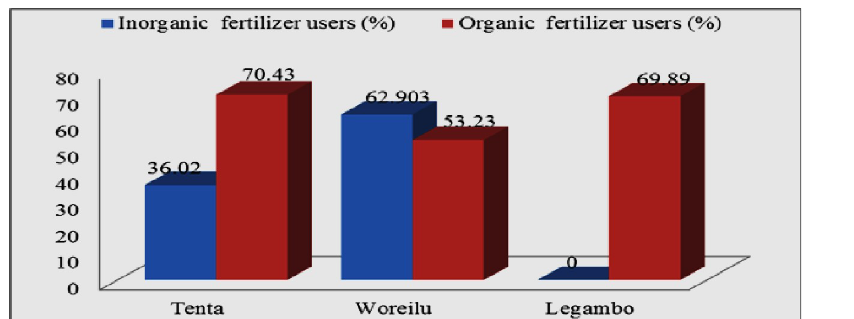
Fig 3. The three district fertilizer utilization and its application.